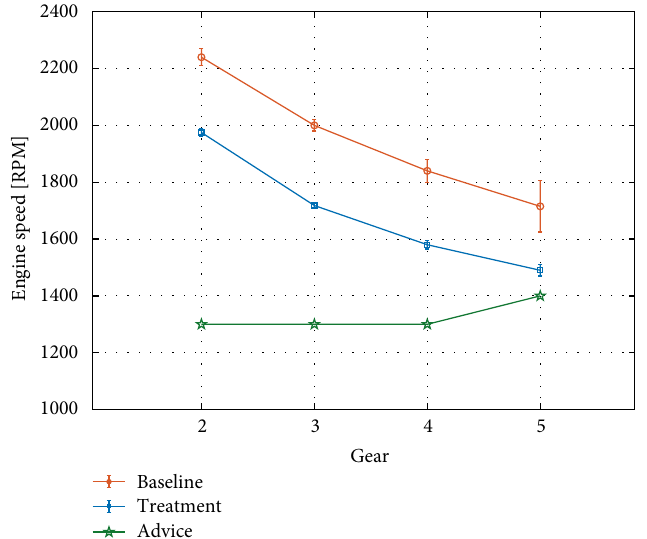
Figure 10: Up shifting behaviour Volvo V70 (6 gears diesel) comparing treatment, baseline and optimal gear shifting points.